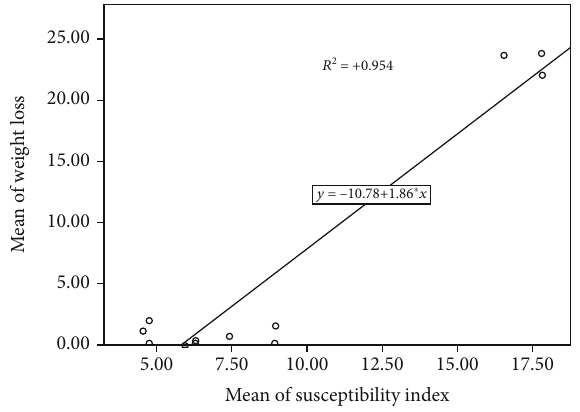
Figure 3: Correlation between DI and percentage weight